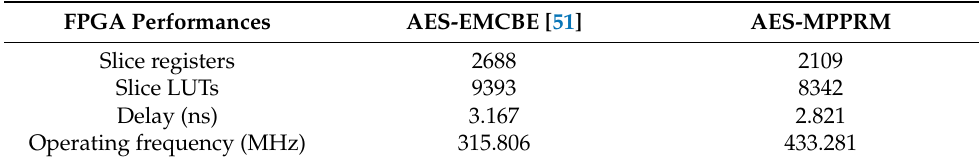
Table 11. Comparison of AES-MPPRM and AES-EMCBE for Virtex 6